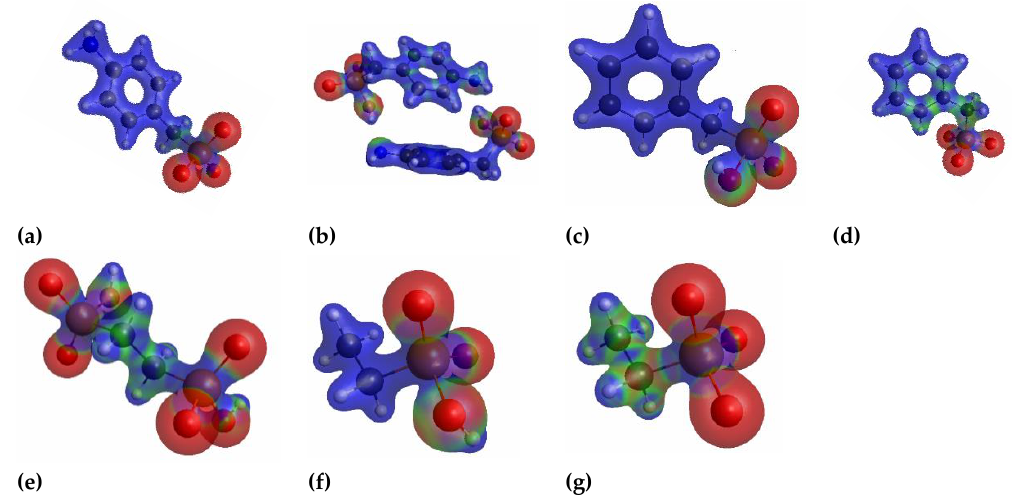
Figure 7. DFT calculated total electron density colored with the Electrostatic Potential Map value for a ) HBPA 1 − , b ) ( HPABPA 1 − ) 2 , c ) HPABPA 1 − d ) BPA 2 − e ) H 2 EDPA 2 − , f ) HEPA 1 − , and g ) EPA 2 − , at the B3LYP/PCM geometry.